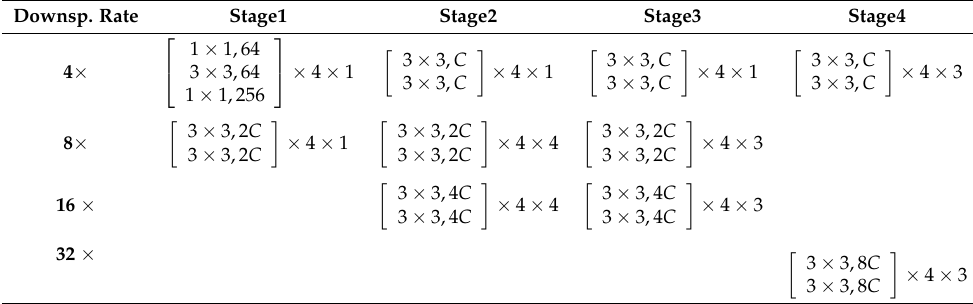
Table 1. Detailed HRNET specifications about every stage and channels. Downsp. Rate Stage1 Stage2 Stage3